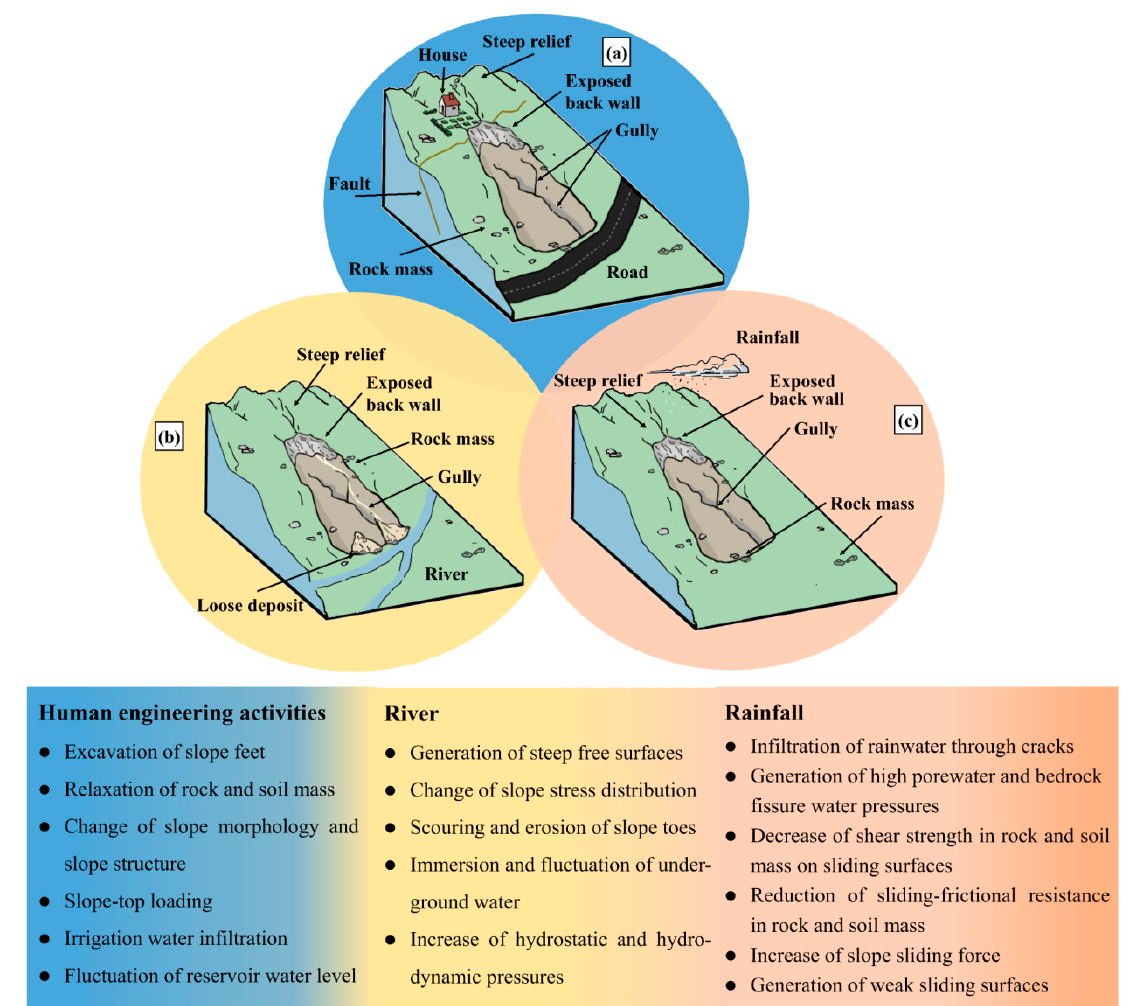
Figure 14. Cause of landslide high-susceptibility in the study area.